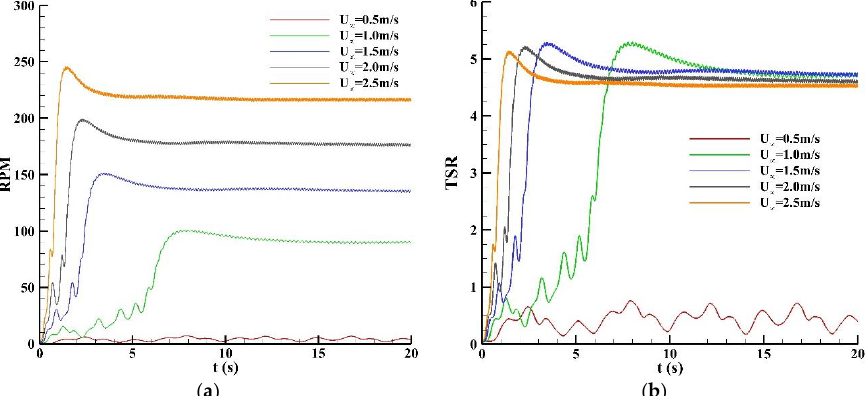
Figure 5. Effects of the incident flow velocity on the rotation speed (No-load condition): ( a ) Revolution per minute (RPM); ( b ) Tip-speed-ratio (TSR).